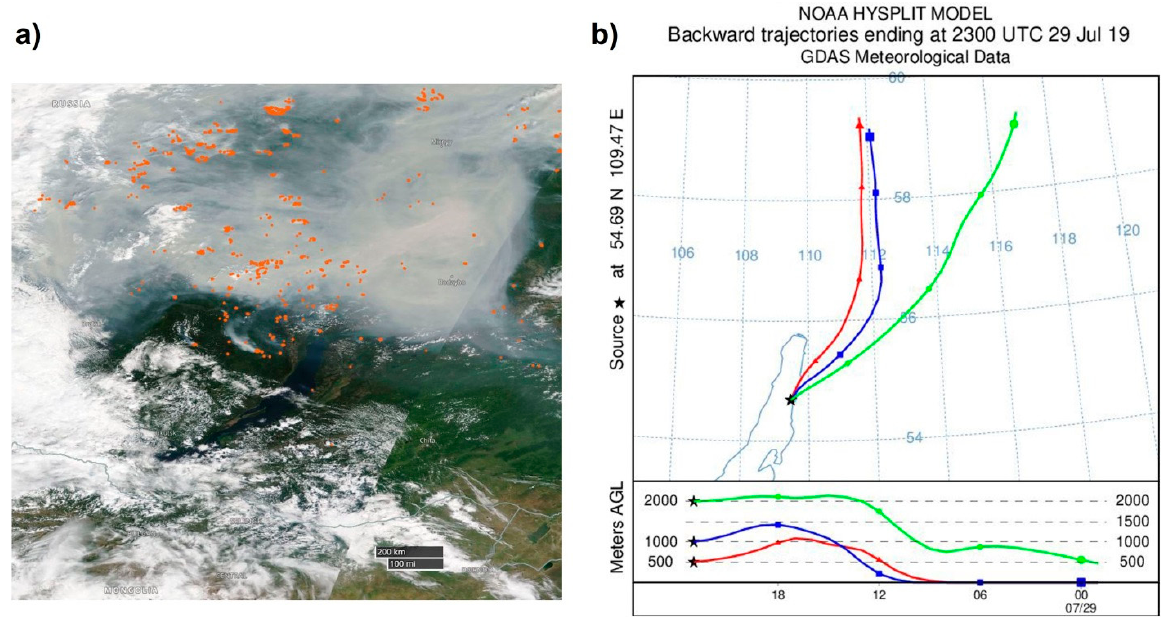
Figure 5. ( a ) Map of wildfires in Siberia in July 2019 [58]; ( b ) Back trajectories of air mass transport to the northern basin of Lake Baikal.